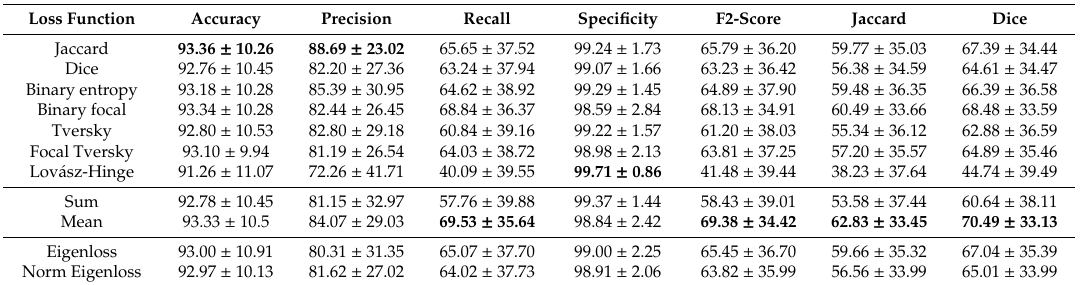
Table 1. U-Net-VGG-16. Results of the model trained with the di ff erent loss functions, reported over the test set of CVC-EndoSceneStill. Best values are indicated in bold.